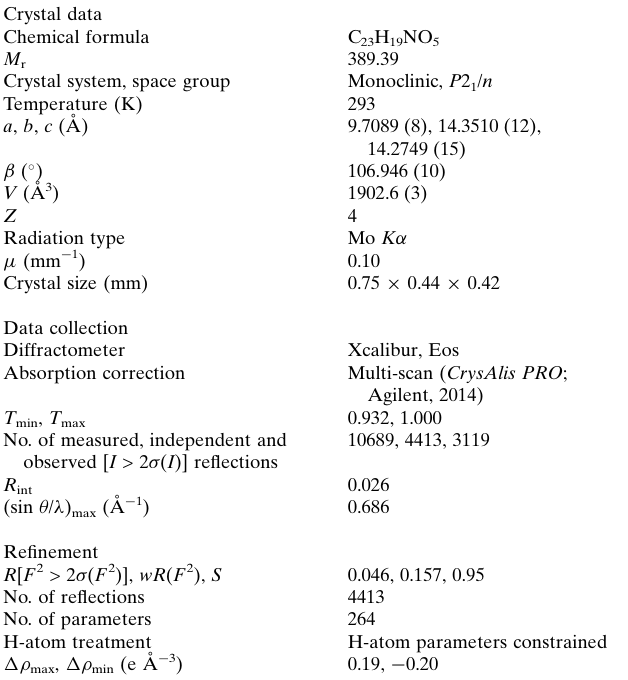
Table 2 Experimental details.